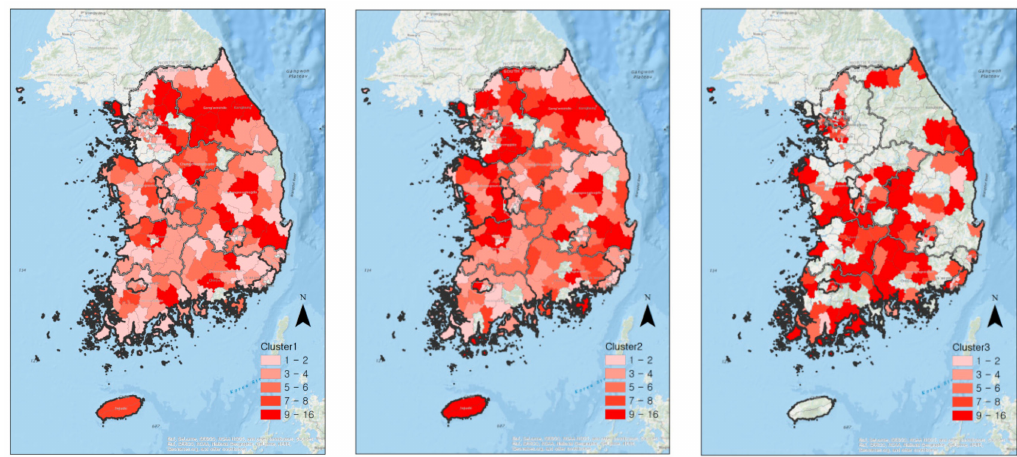
Figure 5. The group-specific spatial distribution resulting from text mining (G1, G2,